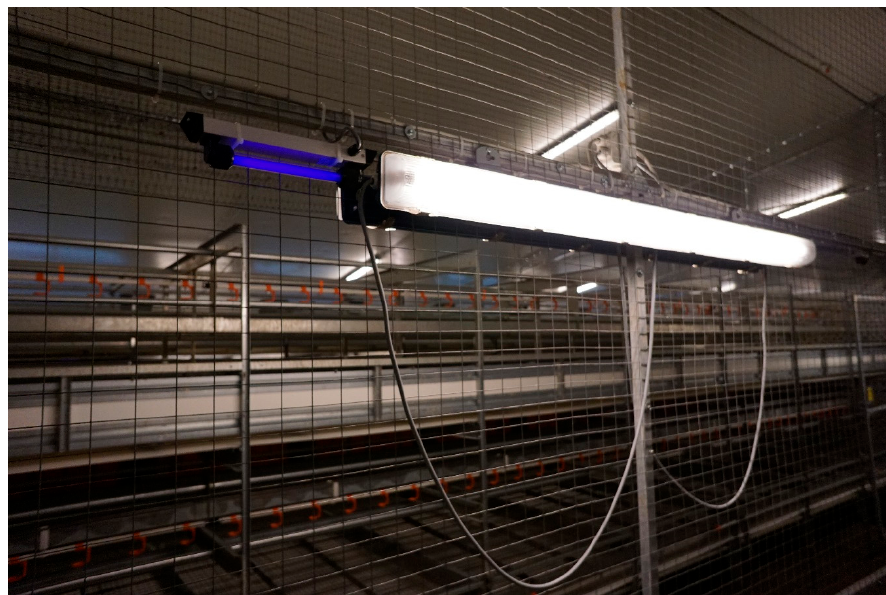
Figure 1. Standard fluorescent lamps (emitting warm white light) as well as black light tubes (emitting long-wave UV-A radiation) were additionally provided in the poultry barn in order to simulate the daylight spectrum in the groups with UV-A light (UVincl).